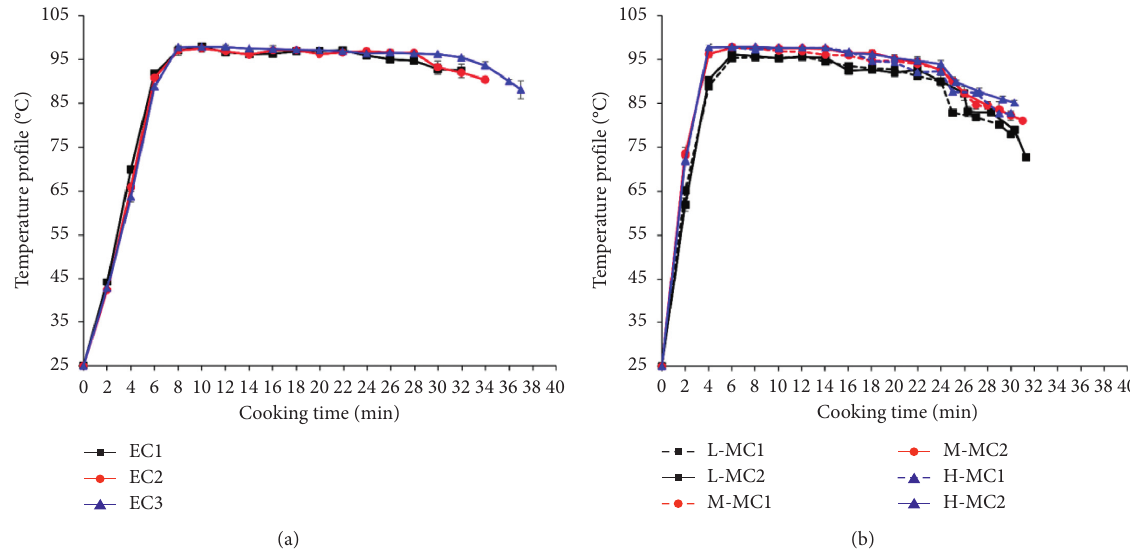
Figure 1: Temperature profile during conventional cooking (a) and microwave cooking (b). EC: conventional cooking using an electric rice cooker, L-MC: microwave cooking using low power level, M-MC: microwave cooking using medium power level, and H-MC: microwave cooking using high power level. 1: low water ratio, 2: medium water ratio, and 3: high water ratio.